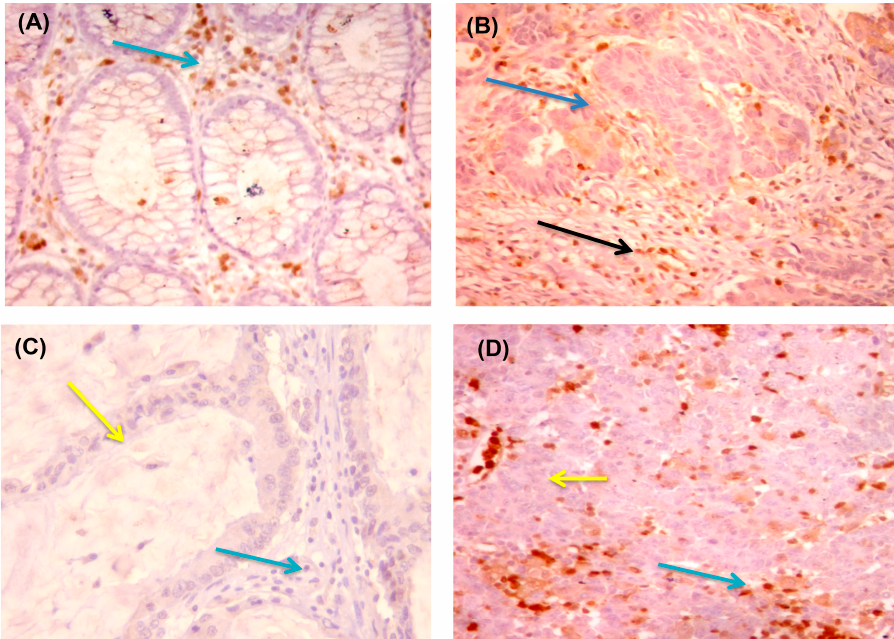
Figure 3. Immunohistochemical staining of colonic adenocarcinoma for PD1. Adjacent non-neoplastic colonic mucosa showed positive staining of the mucosal lymphocytes for PD1 (( A ) × 400), G1 adenocarcinoma showed positive staining of intratumoral immune cells for PD1 (blue arrow) with no expression in tumor cells (yellow arrow) (( B ) × 200 and ( C ) × 400). In addition, G3 adenocarcinoma showed expression of PD1 on intratumoral immune cells (blue arrow) with negative expressions on tumor cells (yellow arrow) (( D ) × 400). N.B., as the lymphocytes have little cytoplasm, the staining appears mainly cytoplasmic.